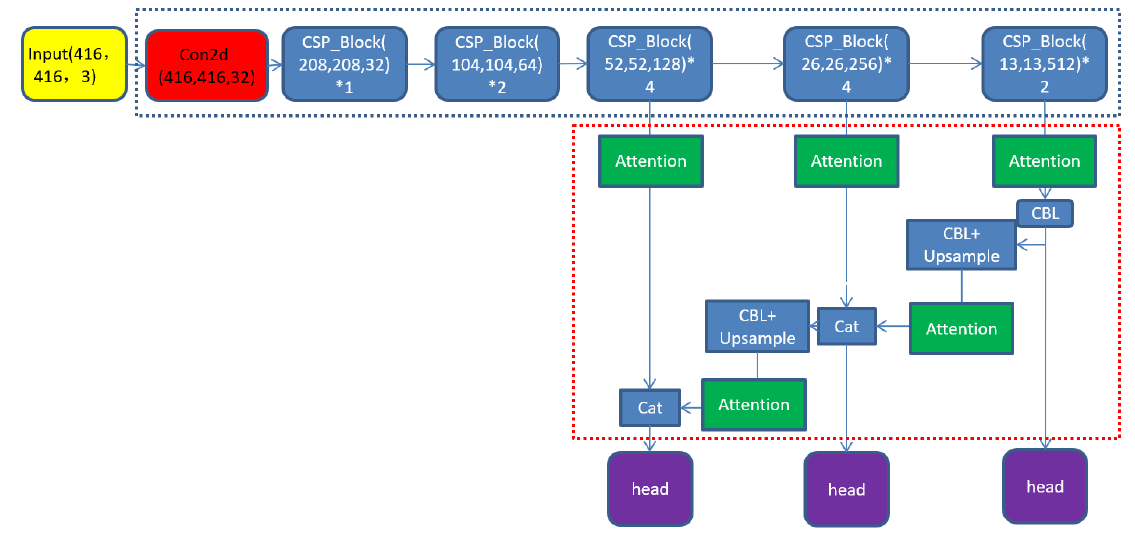
Figure 6. The network after the Add attention mechanism modification.